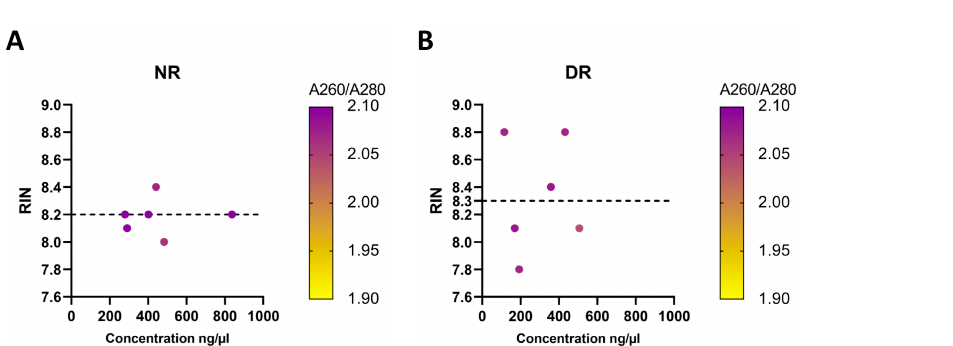
Figure 6. The quantity (ng/ µ L), quality (absorbance ratio A260/A280 nm), and integrity (RIN) of samples extracted from ( A ) normal rats (NR) ( n = 6) and ( B ) diabetic rats (DR) ( n = 6) using our optimized protocol. The dashed horizontal line represents the mean RIN.